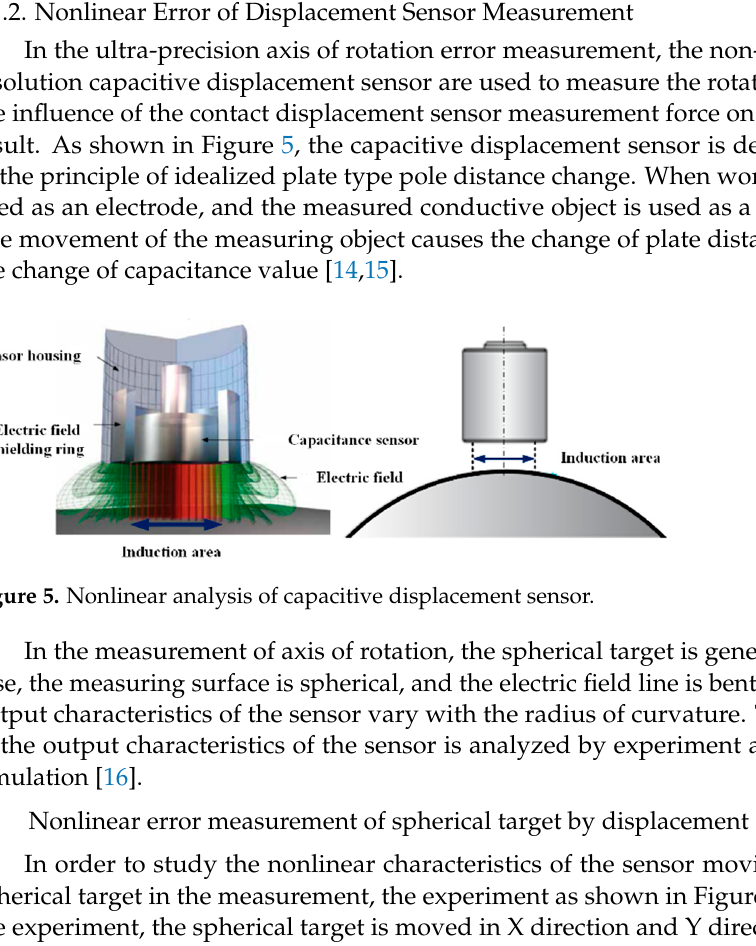
Figure 5. Nonlinear analysis of capacitive displacement sensor.